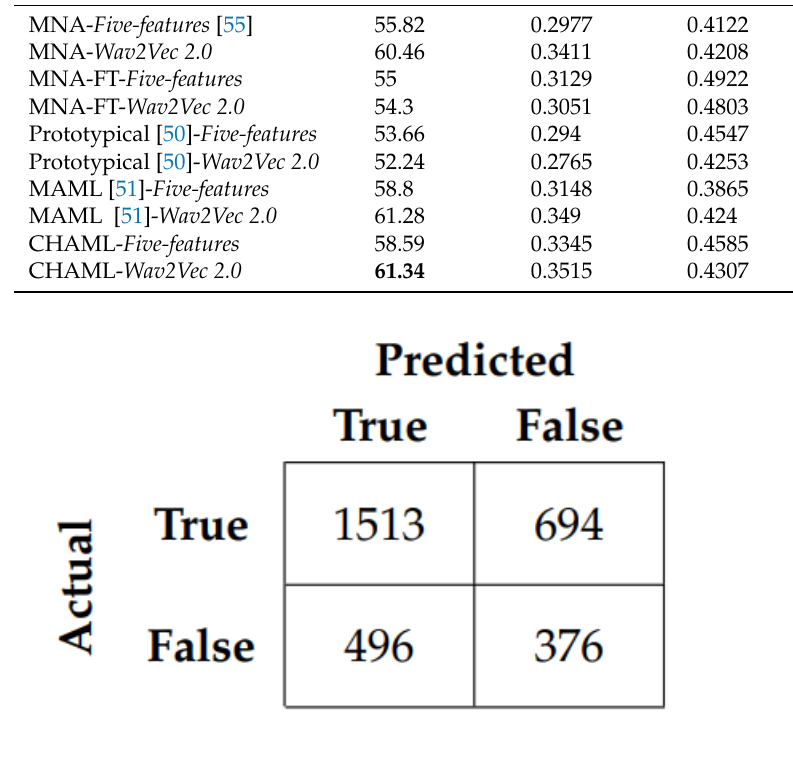
Figure 4. CHAML—Wav2Vec 2.0 performance on the query set of the test